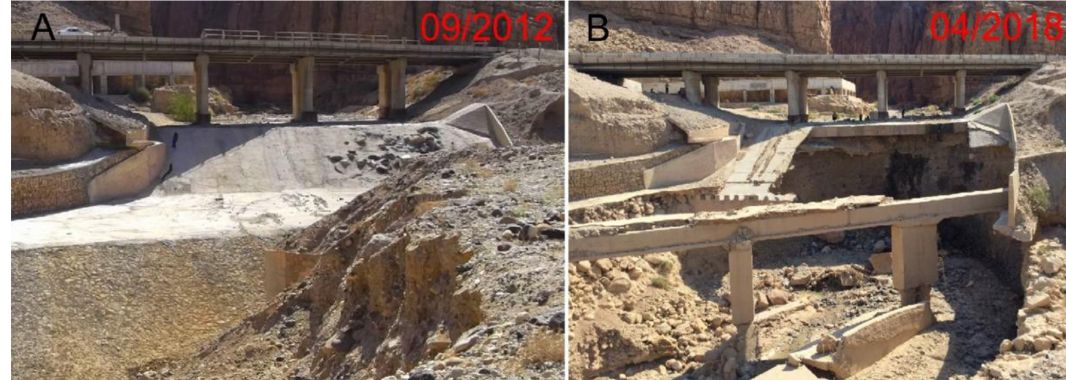
Figure 10. Example of a bridge along the Dead Sea motorway damaged by progressive erosion of the sediments. All bridges along the Dead Sea coast are affected by the rapid incision of the river